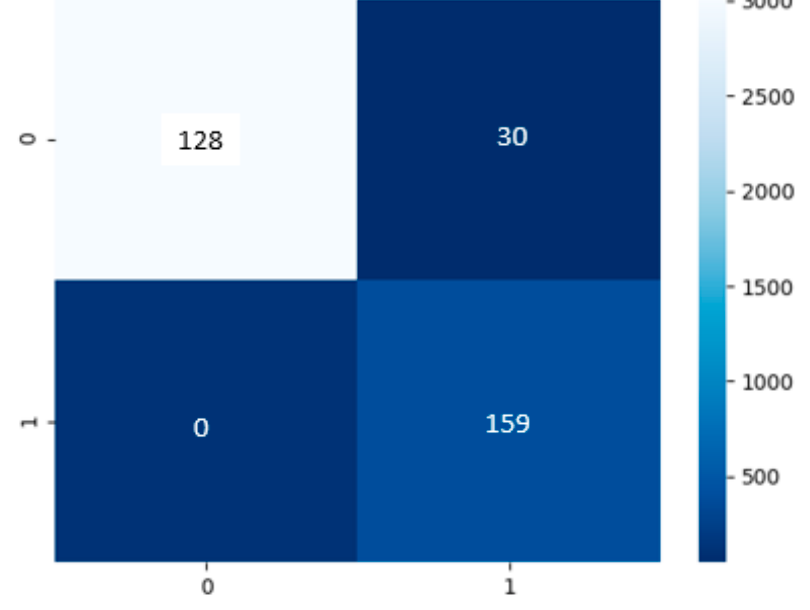
Figure 10. Figure 10. Cough Model Confusion Table 6. COVID-19 Cough Model Performance Table.